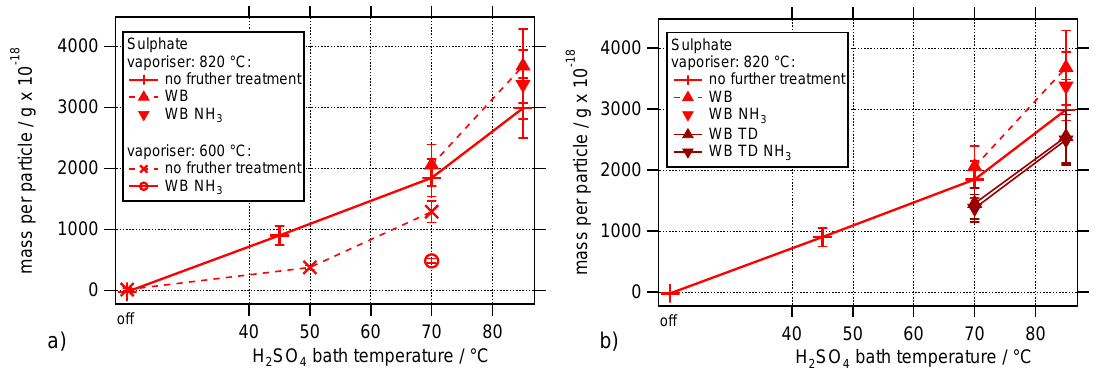
Fig. 5. Left: sulphate mass per particle for H 2 SO 4 coatings with additional humidification (WB) and optional neutralisation by NH 3 detected at vaporiser temperatures of 600 ◦ C and 820 ◦ C. Right: sulphate mass per particle for the 820 ◦ C vaporiser data of the left graph, treated additionally by the thermodenuder (TD).